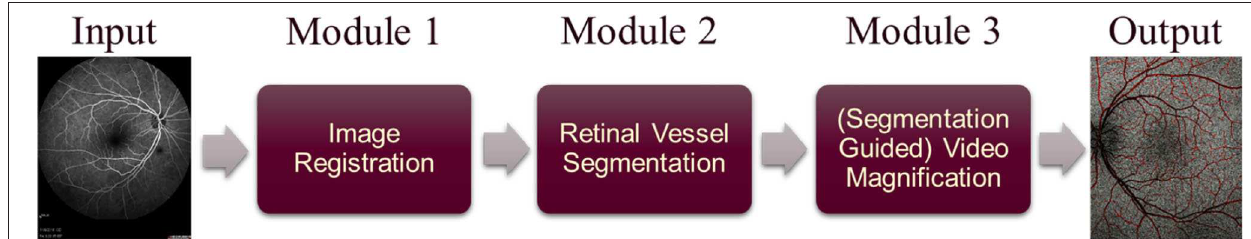
FIGURE 5 | Overview of the proposed approach.